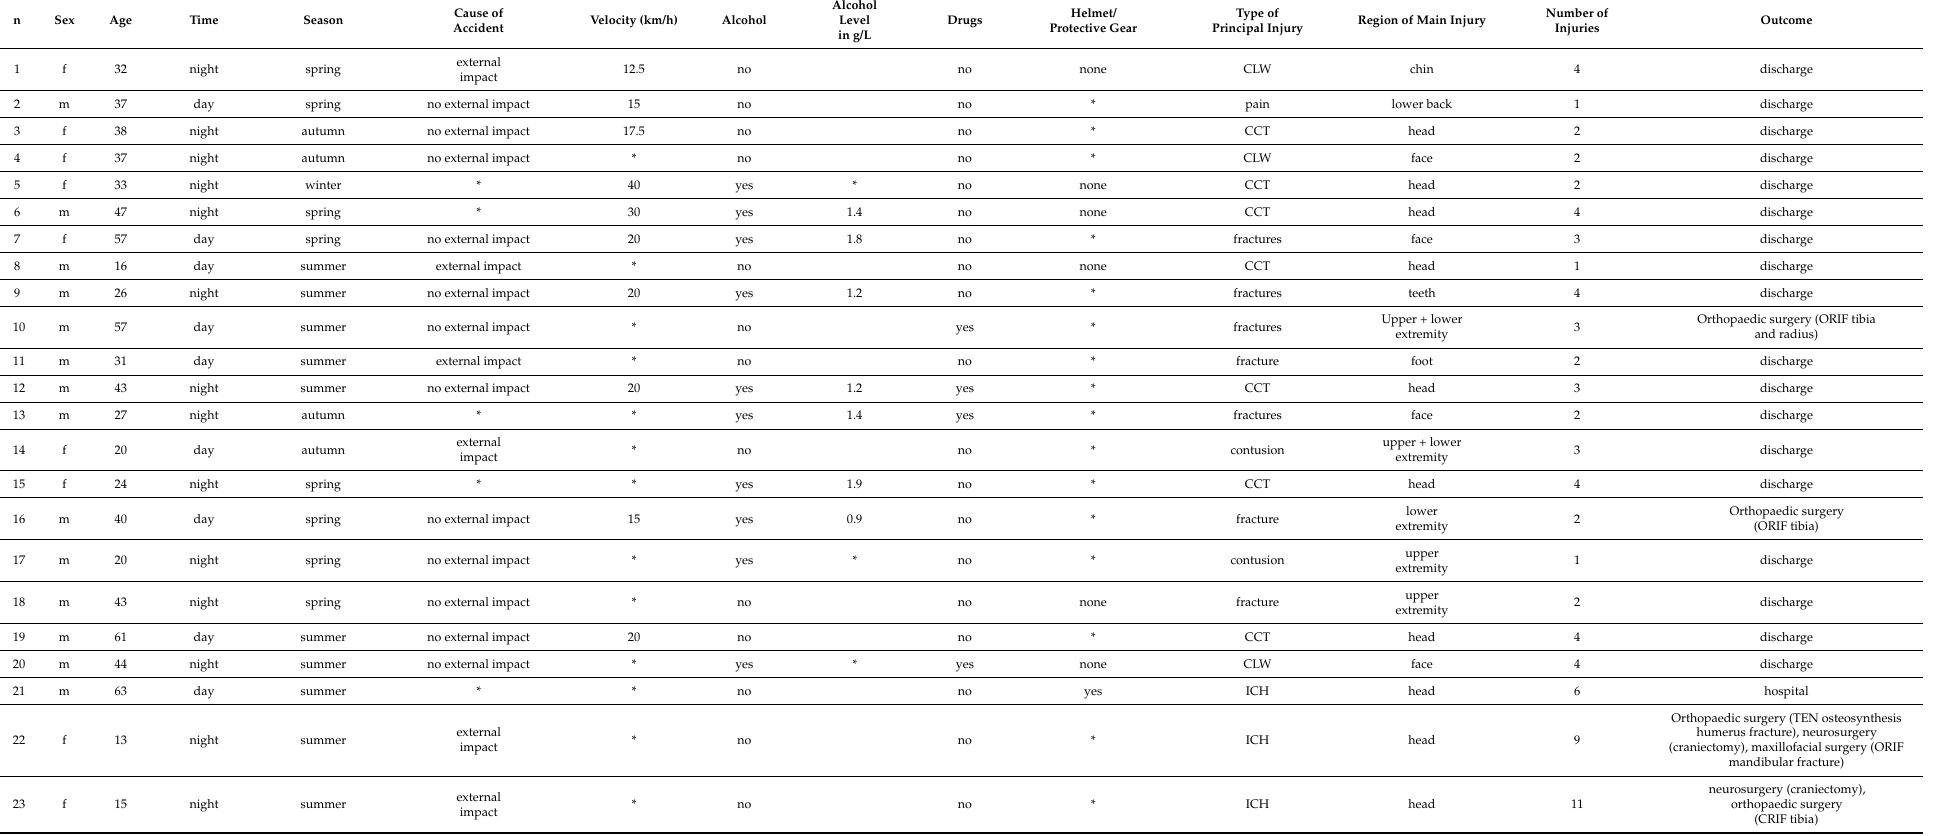
Abbreviations: CLW = contused lacerated wound, CCT = craniocerebral trauma, ICH = intracranial haemorrhage, * = missing